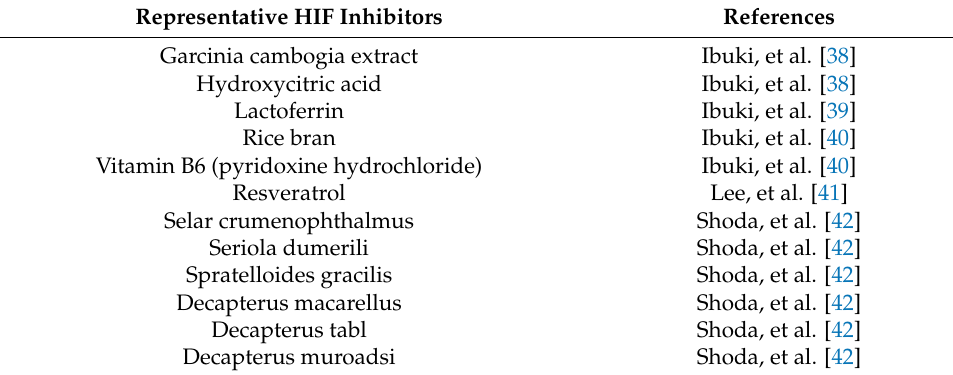
Table 1. The list of foods or extracts that inhibit HIF showing a significant decrease in the amount of CNV in